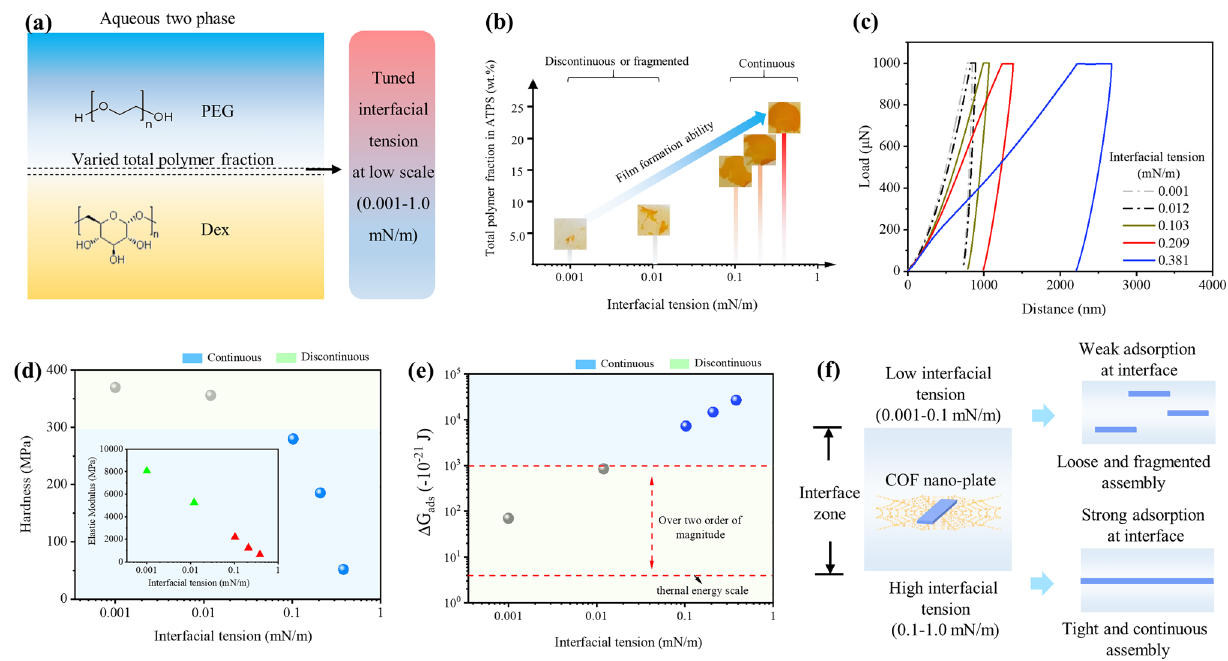
Fig. 4 Influence of interfacial tension on formation of COF-DhTG Cl membranes. a Scheme of tuning interfacial tension by changing total poly- mer fraction in aqueous two-phase system. b Film formation, c indentation depth curves, d hardness and elastic modulus, e interfacial adsorption energy and f spread-assembly process of COF-DhTG Cl membranes under different interfacial